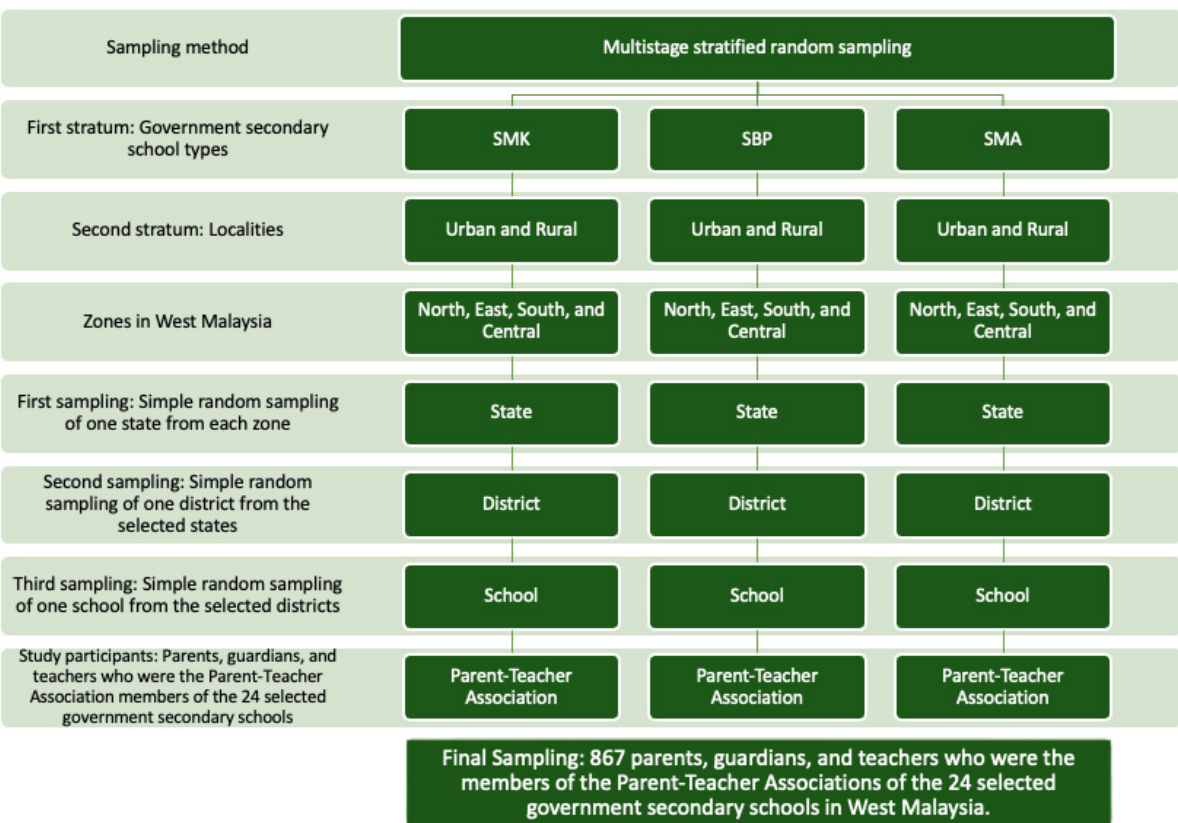
Figure 1. Multistage stratified random sampling for the current study.